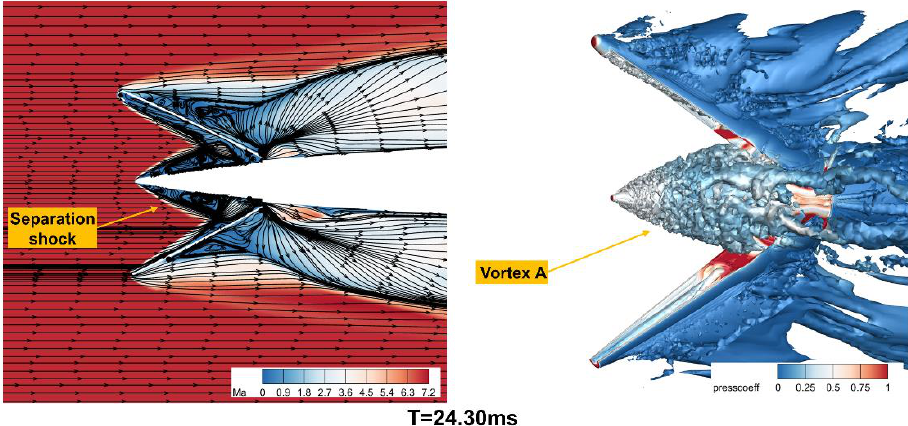
at Time = 21.60 ms.